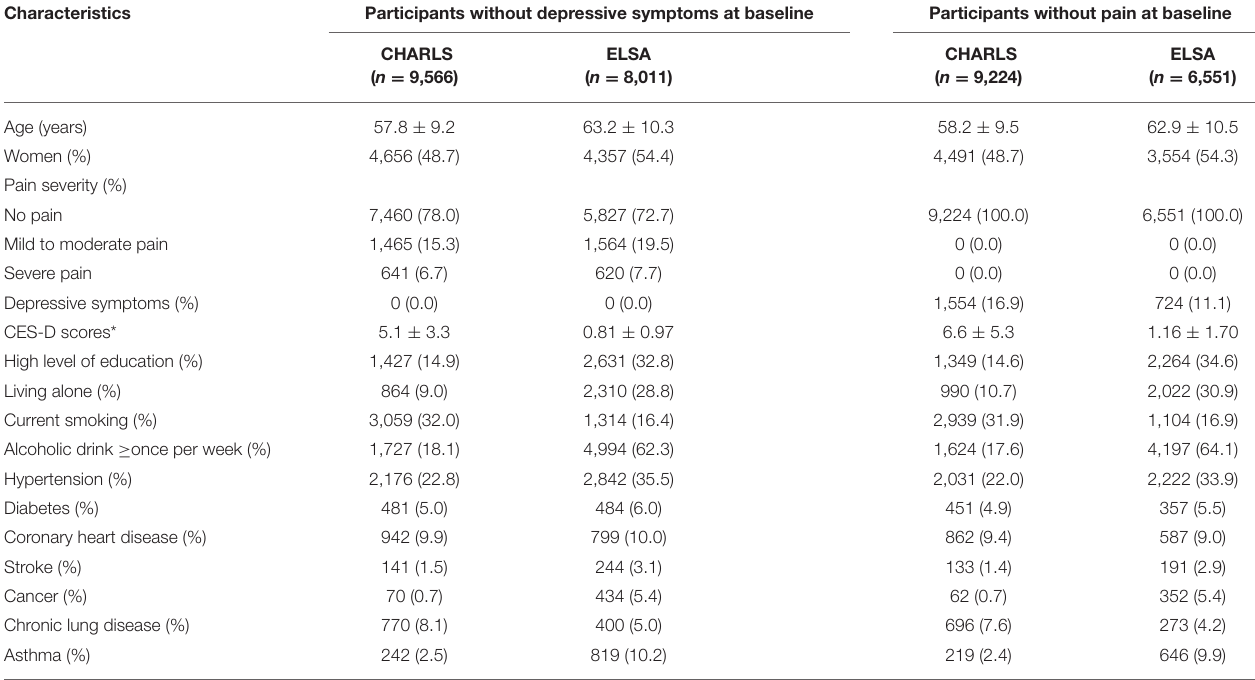
TABLE 1 | Characteristics of participants in the China Health Retirement Longitudinal Study (CHARLS) and the English Longitudinal Study of Aging (ELSA) at baseline. Characteristics Participants without depressive symptoms at